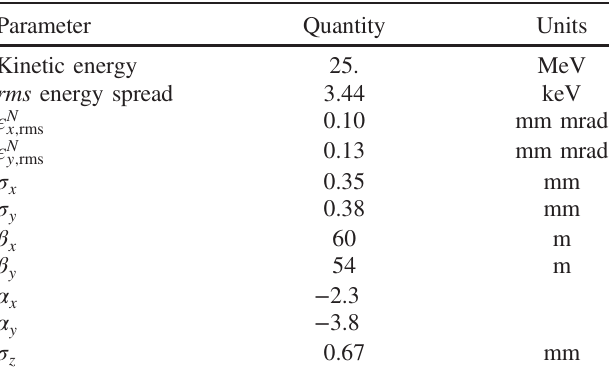
TABLE X. Properties of electron bunch at linac exit.